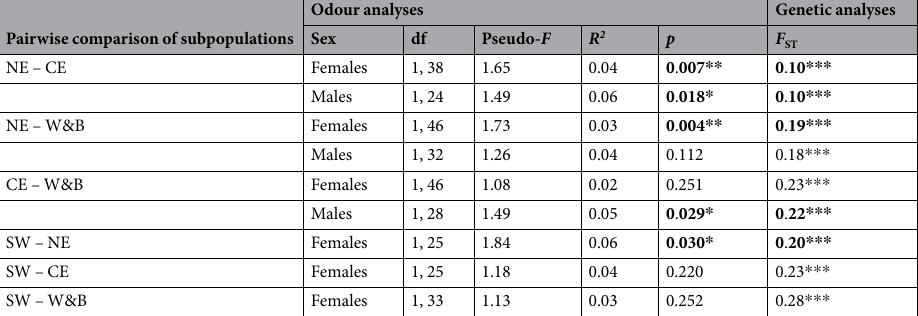
Table 2. Otter odour (PerMANOVA analysis) and genetic ( F ST ) pairwise comparisons between subpopulations, for males and females separately. The lack of male samples from South-west England prevented pairwise comparisons. W&B = Wales and Borders, SW = South-west England, NE = North England, CE = Central England. Bold font indicates statistical significance (p < 0.05) for both odour and genetic analyses. * p < 0.05, ** p < 0.01, *** p <